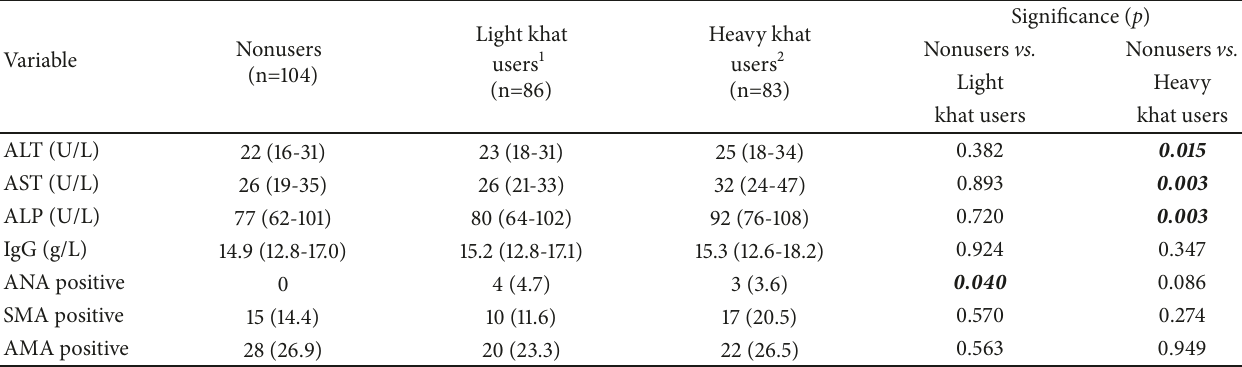
Table 2: Laboratory findings in the study participants, by khat consumption